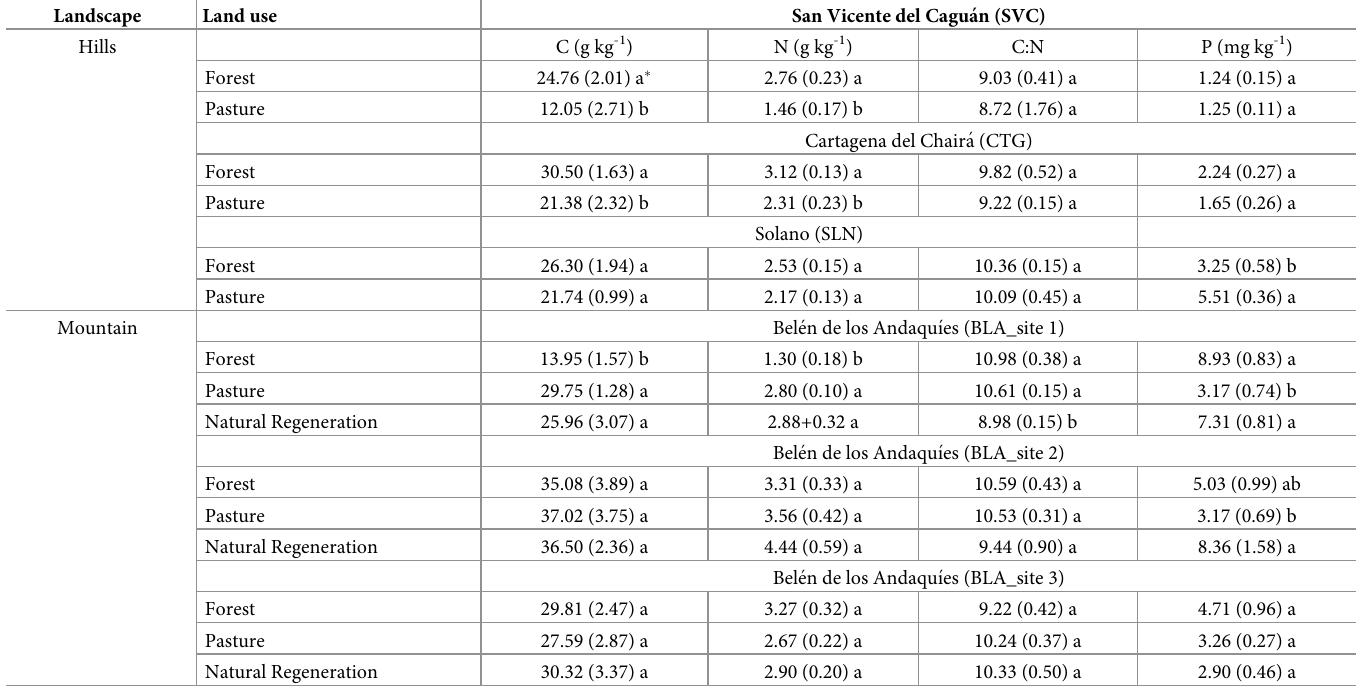
Table 3. Soil C, N, C:N ratio, and P in forest, pasture, and natural regeneration in the Colombian Amazon region.